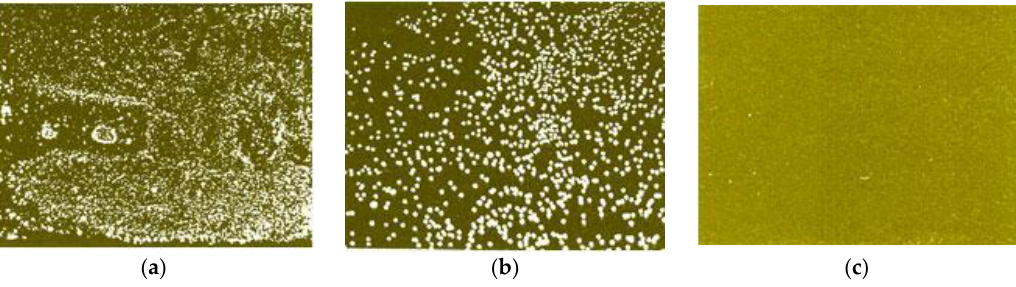
Figure 1. ( a ) Uncleaned (rinsed only), many bacterial colonies; ( b ) after chemical cleaning, reduced numbers of bacterial colonies; and ( c ) after cleaning and disinfection, very few bacterial colonies remain [4]. Table 5. Available disinfectant and their usage [4].